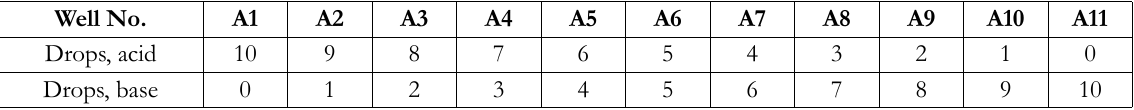
Table 2. The composition in the preparation of a mixed solution of an acid and a base made in the holes of a 96-well microplate